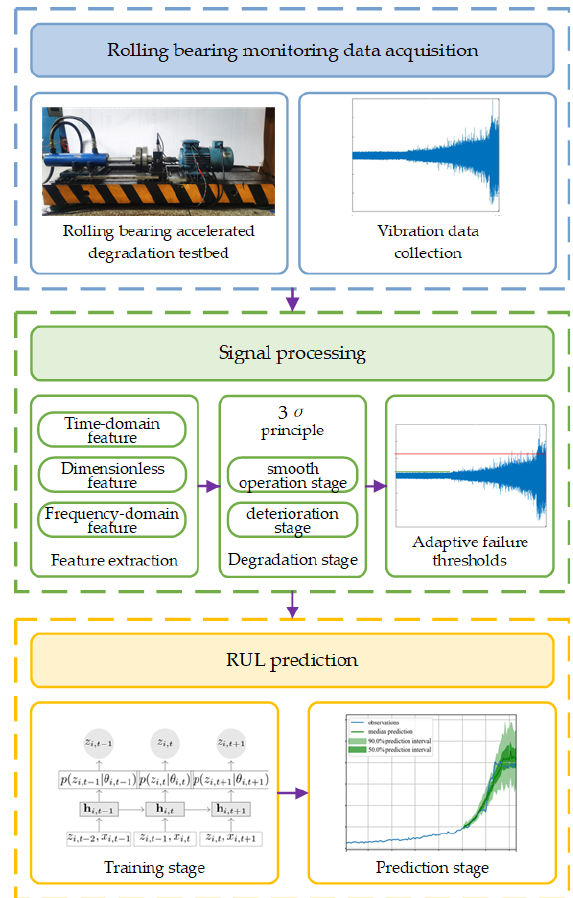
Figure 4. Flowchart of rolling bearings RUL prediction.